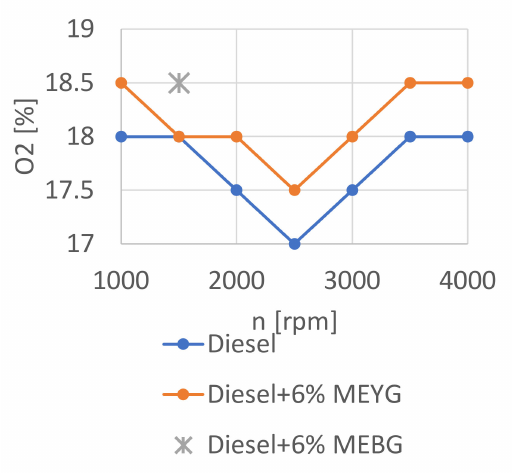
Figure 14. The amount of O 2 in exhaust gas at full engine